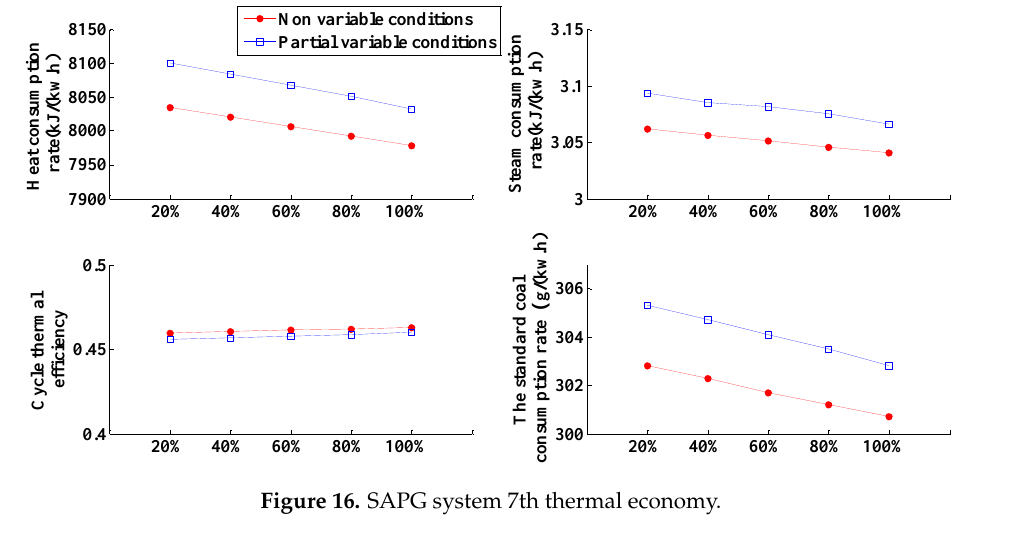
Table 8. Pressure error of substituting the 1st stage.